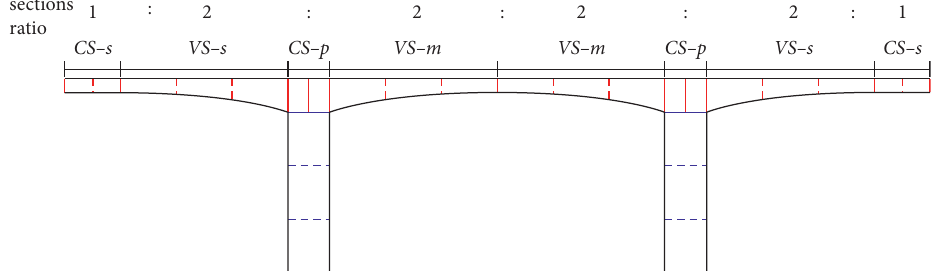
Figure 1: Schematic diagram of main beam and pier section selection.